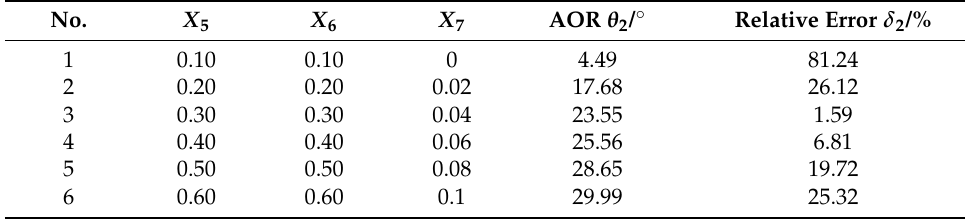
Table 5. Design scheme and results of Steepest Ascent